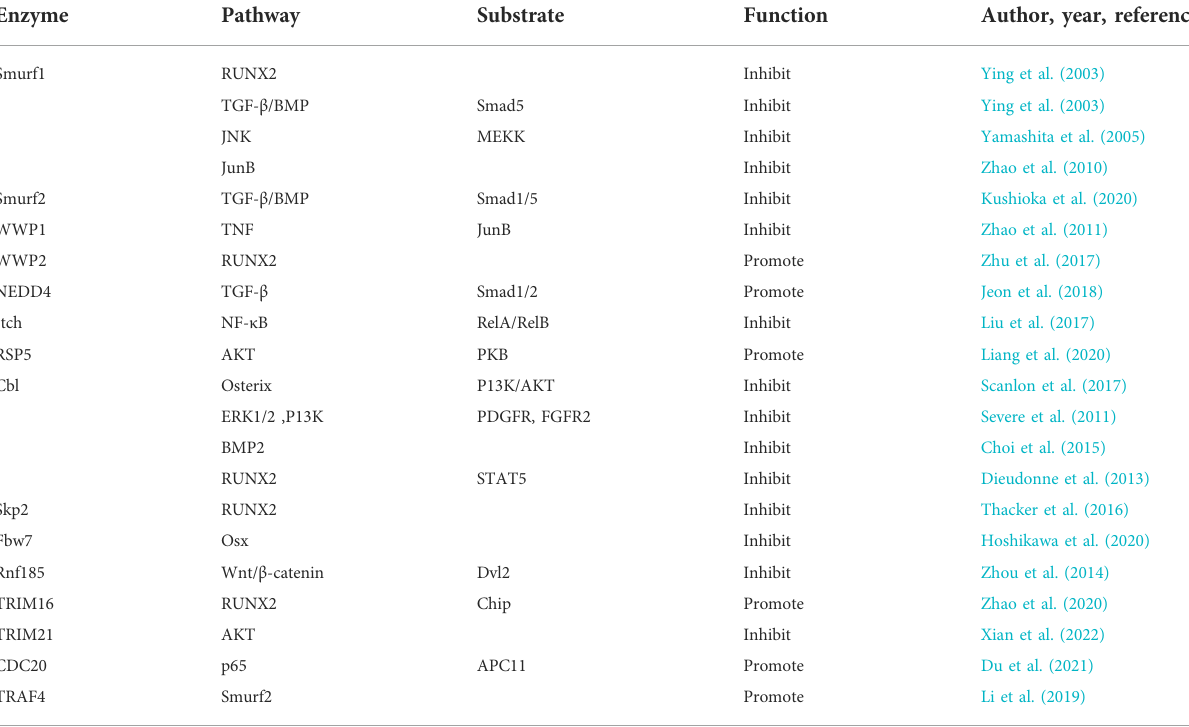
TABLE 2 The mechanism and effect of E3 on osteogenic differentiation of MSCs.